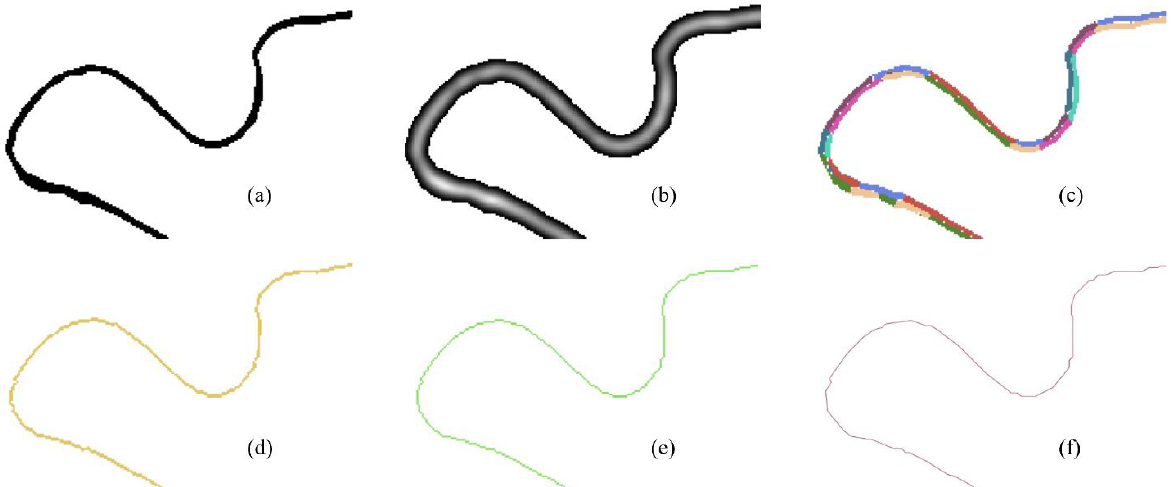
Figure 4. An illustration of the proposed method: ( a ) The lotic habitat image object in the raster format; ( b ) the magnitude surface generated from the WFSC; ( c ) the derived discrete aspect image; ( d ) the traced centerline from opposite aspect codes; ( e ) the thinned centerline in the raster format; and ( f ) the delineated centerline in the vector format.